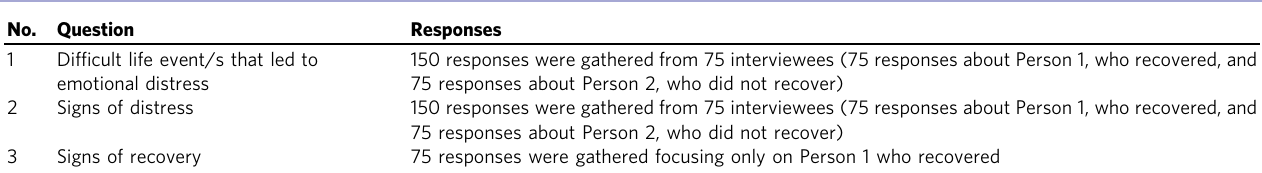
Table 1 Questions asked during case study interviews and number of responses gathered. No.